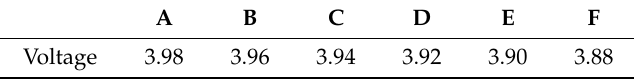
Figure 6. Circuit diagrams of SSIE ( a ), PAE ( b ) and NIBNDE ( c ) with six cells. Table 4. The initial cell voltages of the six cells (voltage unit: V).